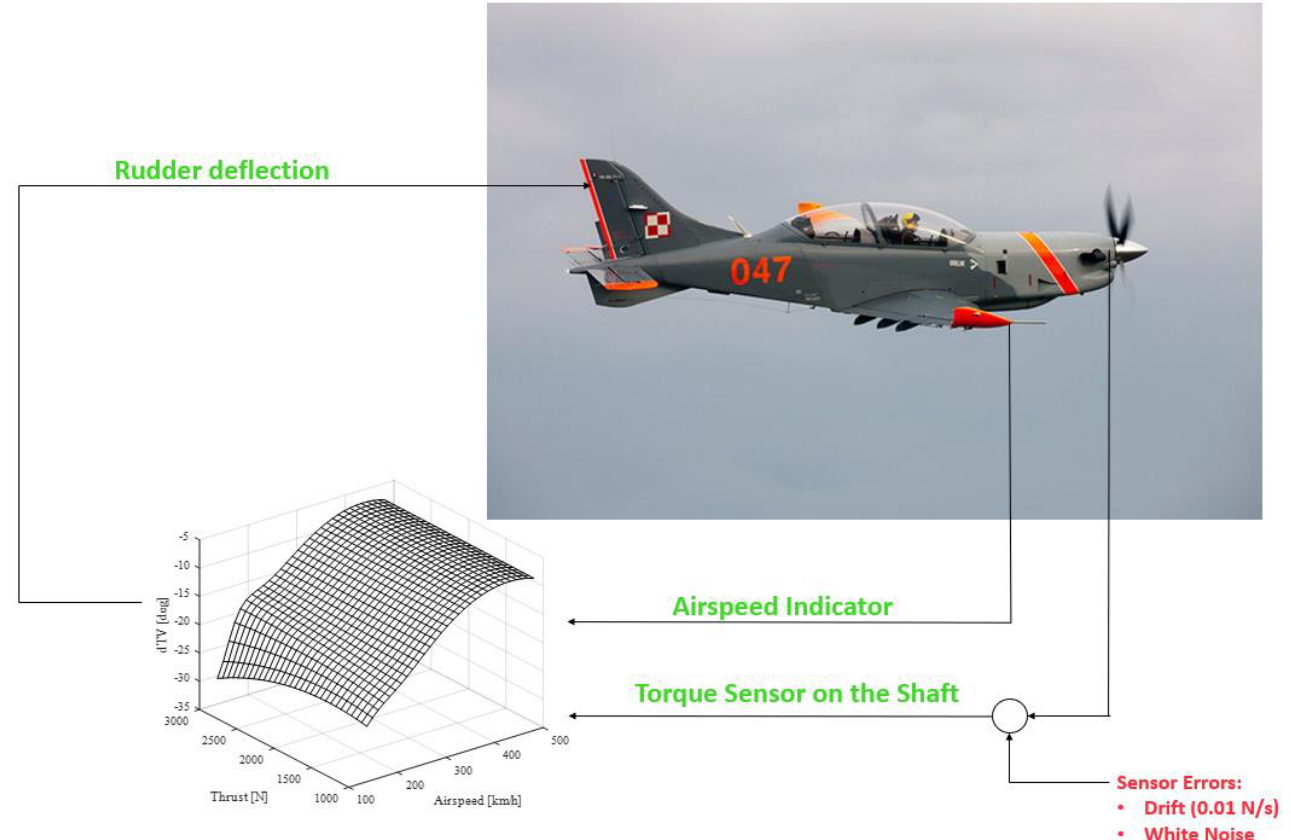
Figure 6. Structure of the ATSK